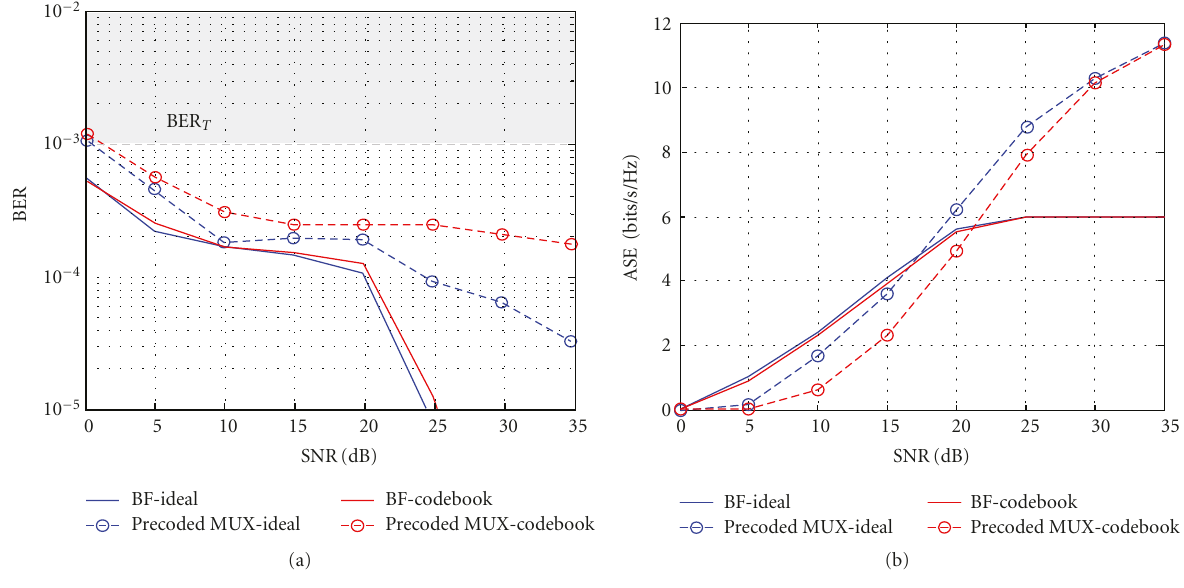
Figure 13: Performance degradation due to codebook based